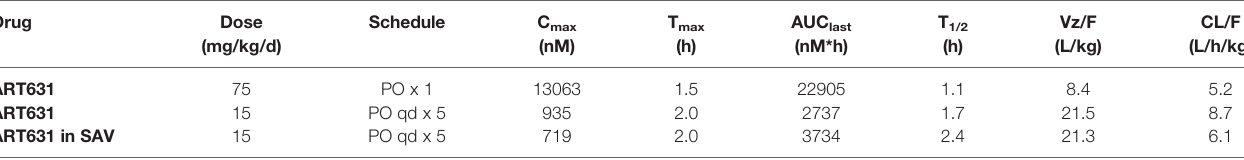
TABLE 4 | PK parameters for 2C-ARTs after single dose and fi ve-day oral regimens. Drug